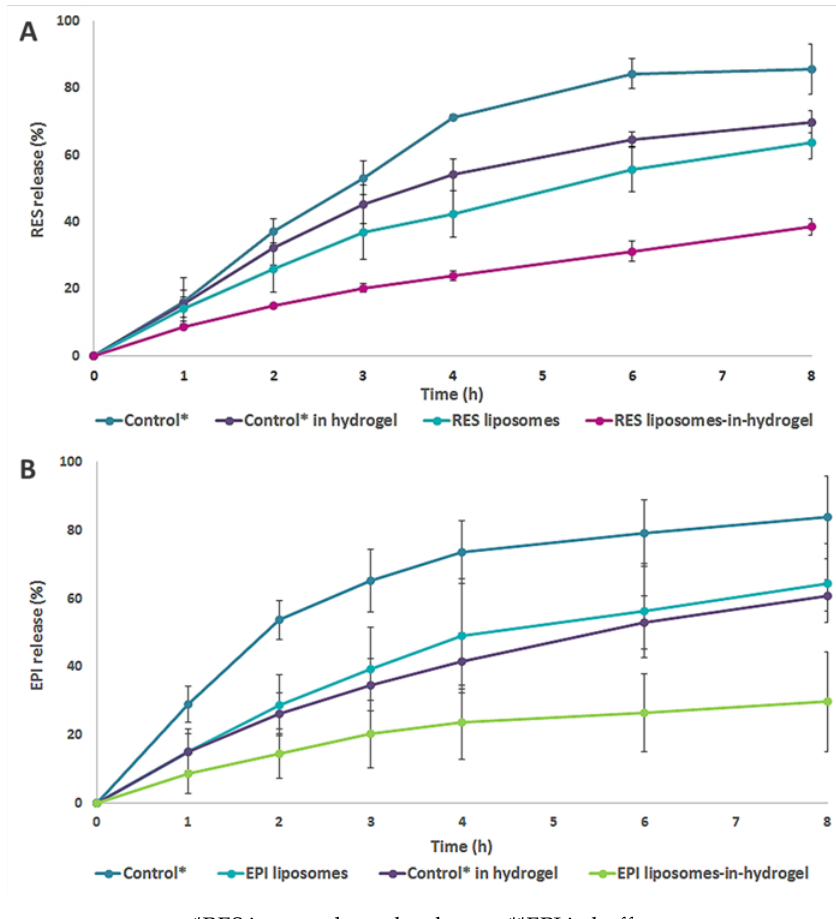
Figure 5. RES ( A ) or EPI ( B ) release from liposomes and liposomes-in-hydrogel compared to the respective controls. Results are expressed as percentage mean ± SD ( n = 3).